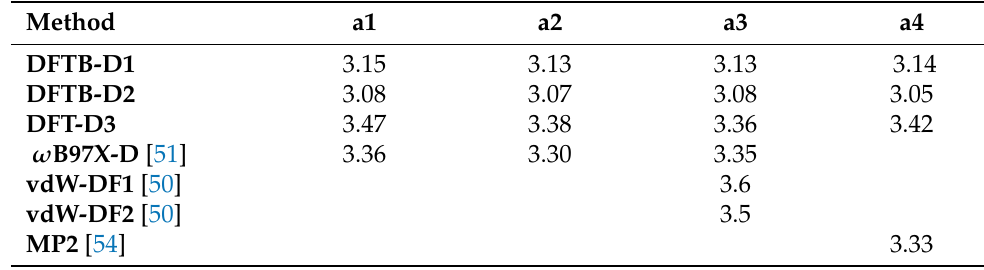
Table 3. Z-separation of benzene on graphene (in